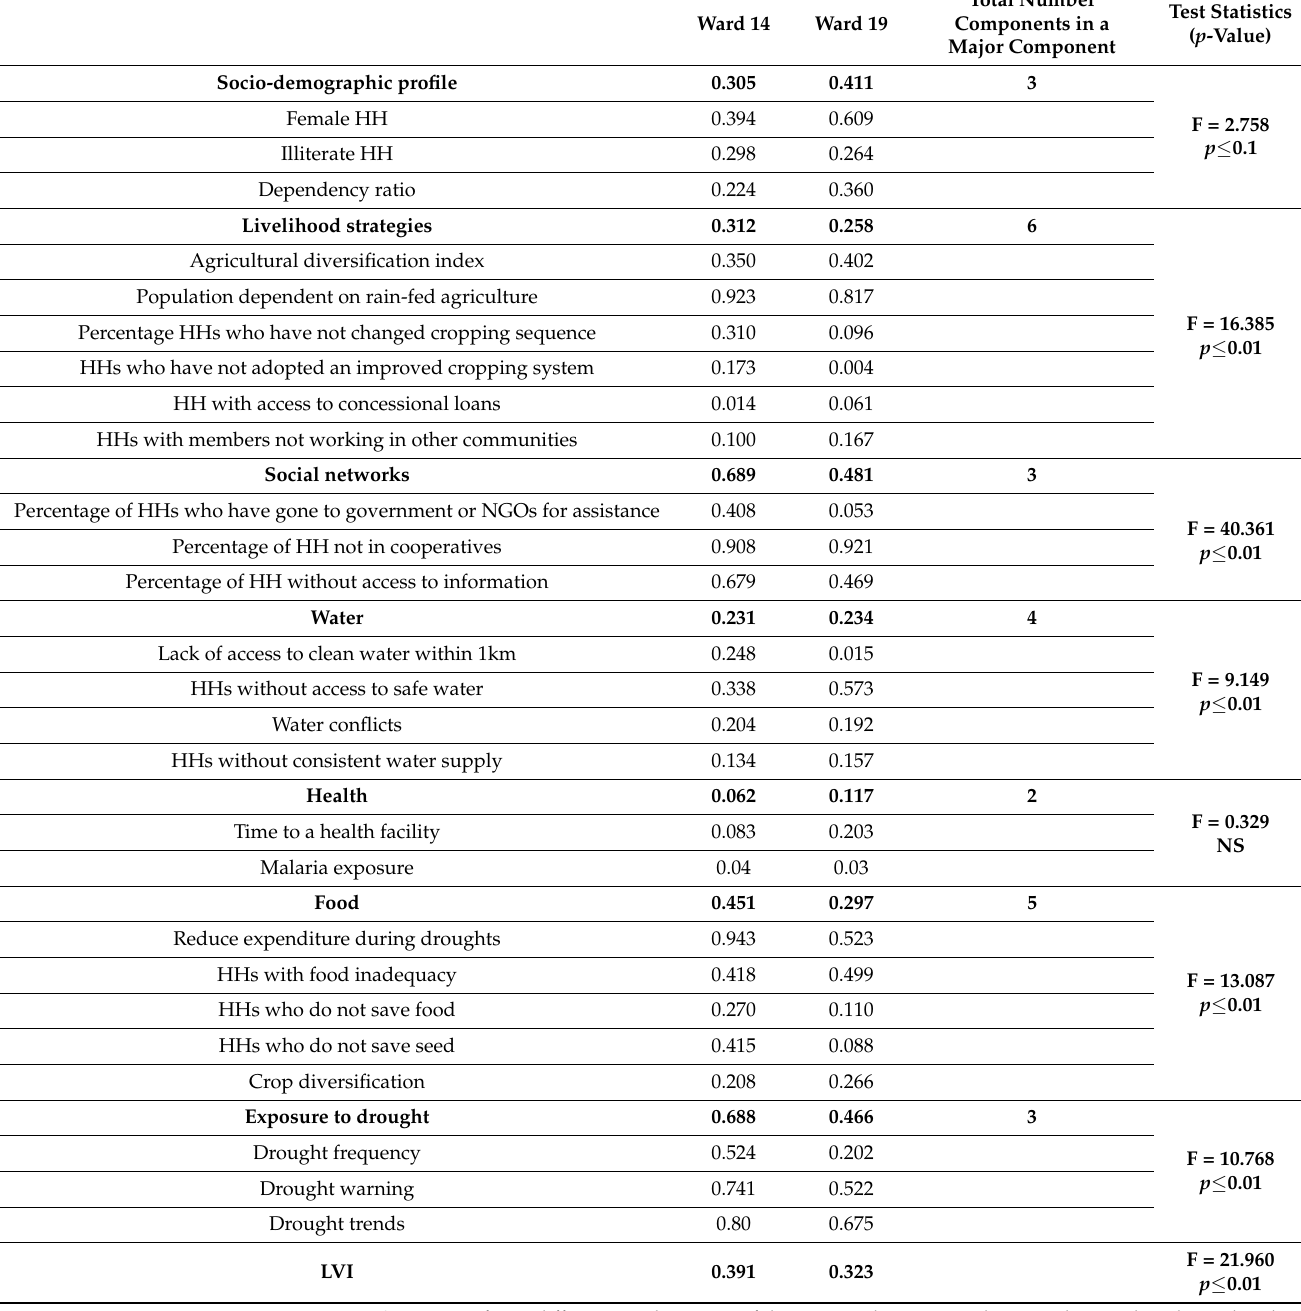
Table 1. Sub-components, components, and LVI of wards 14 and 19 in Chivi